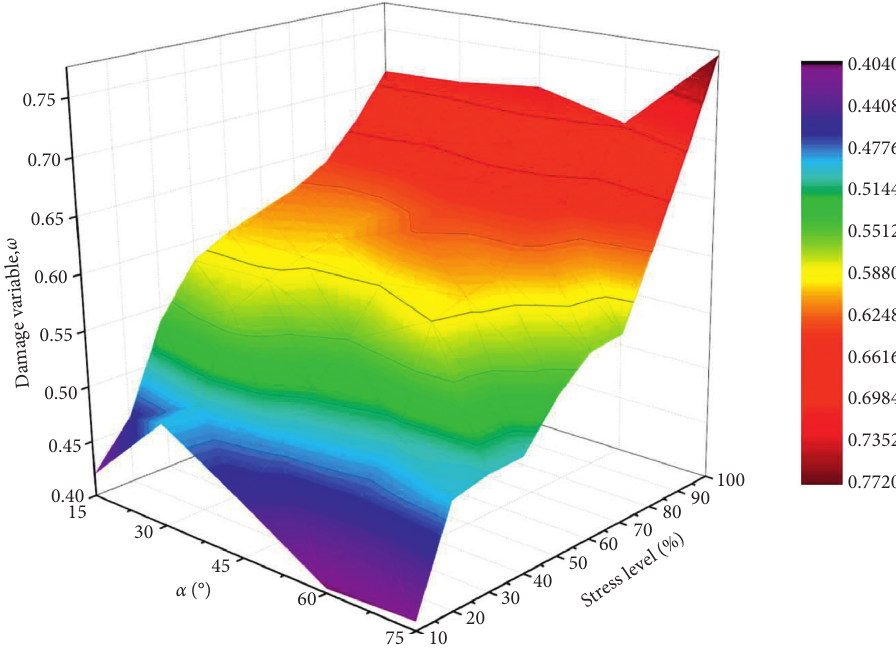
Figure 14: Relationship between damage variable, stress levels, and